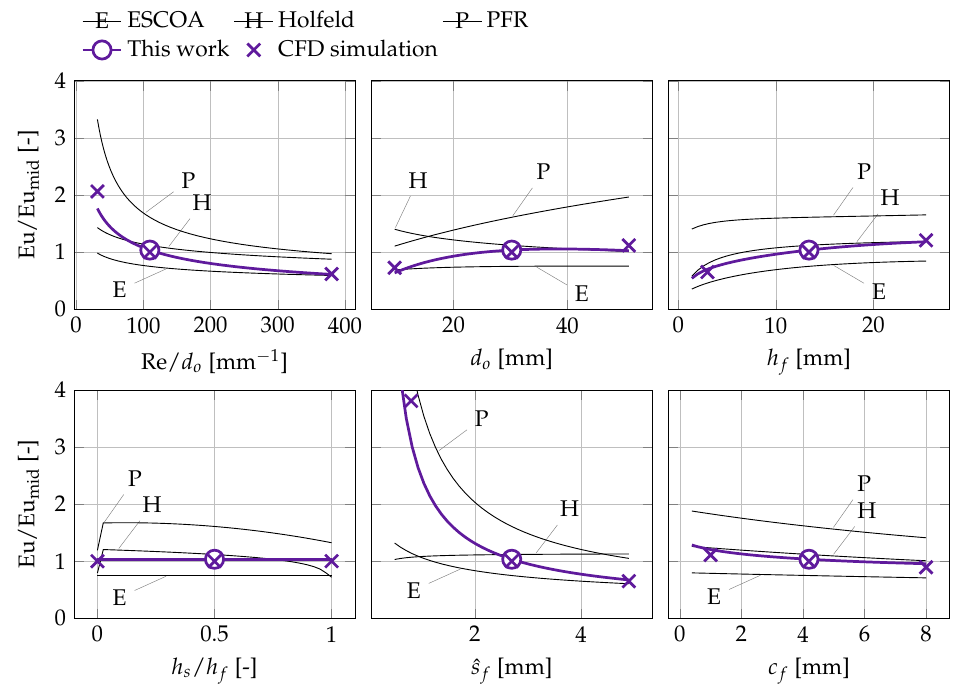
Figure 5. Trends in correlations and CFD simulator around the midpoint in the design space (marked by a circle). CFD simulations were independently sampled (not part of the dataset used for model development). Each parameter was varied independently, with remaining parameters held